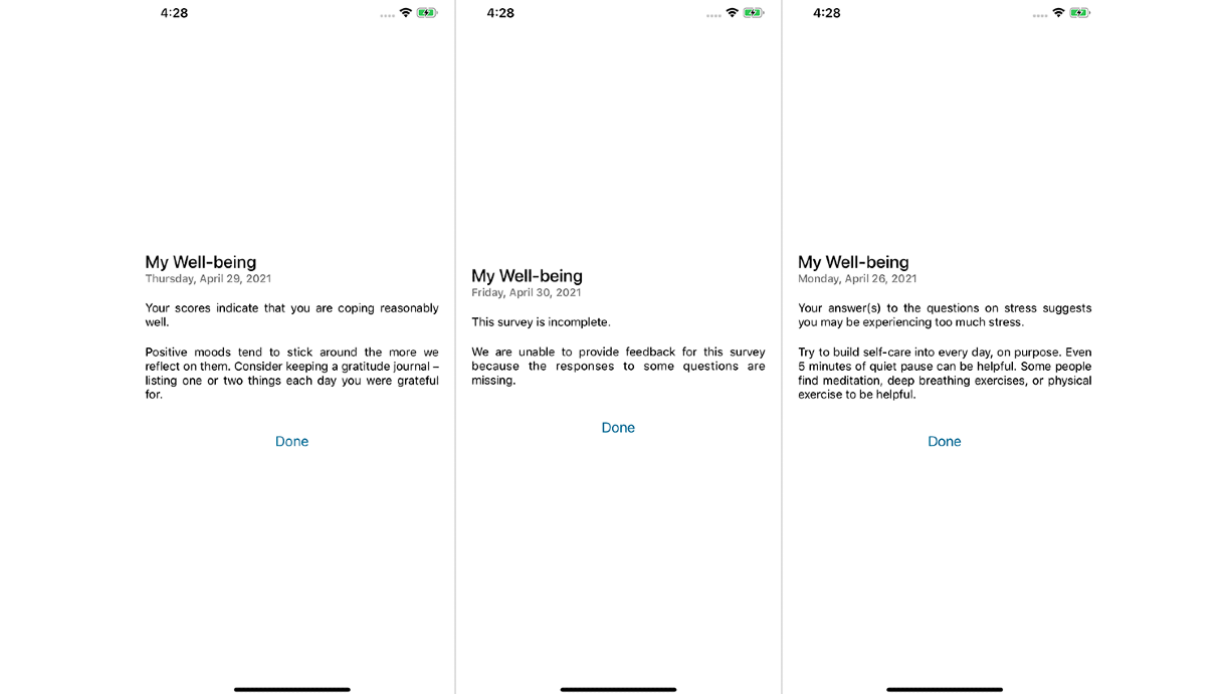
Figure 2. Randomized feedback based on survey score: good (left), incomplete (middle), or cautionary